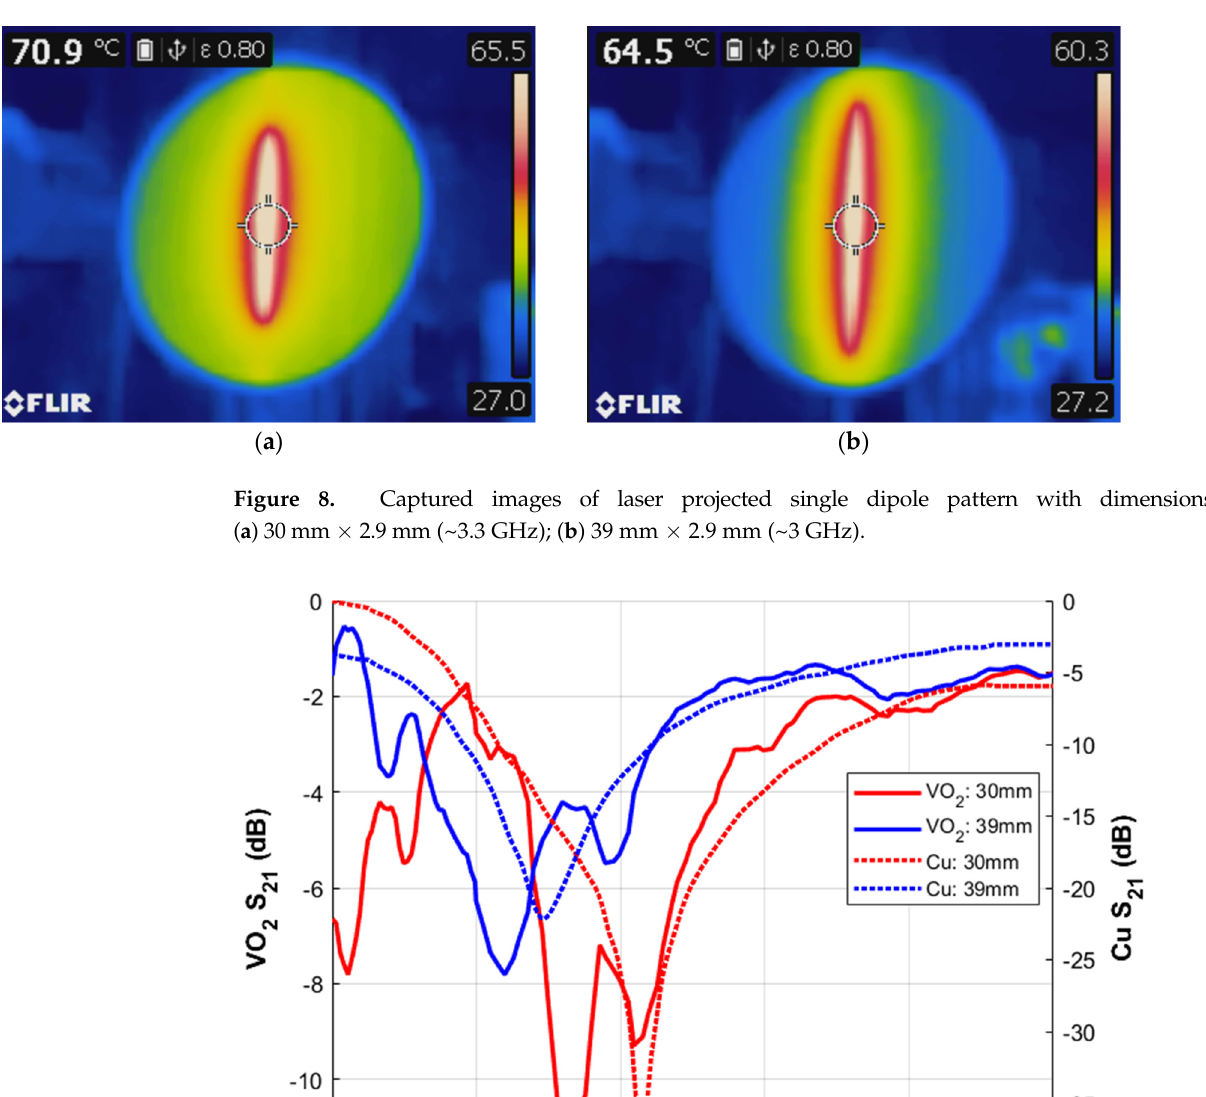
Figure 8. Captured images of laser projected single dipole pattern with dimensions: ( a ) 30 mm × 2.9 mm (~3.3 GHz); ( b ) 39 mm × 2.9 mm (~3 GHz).